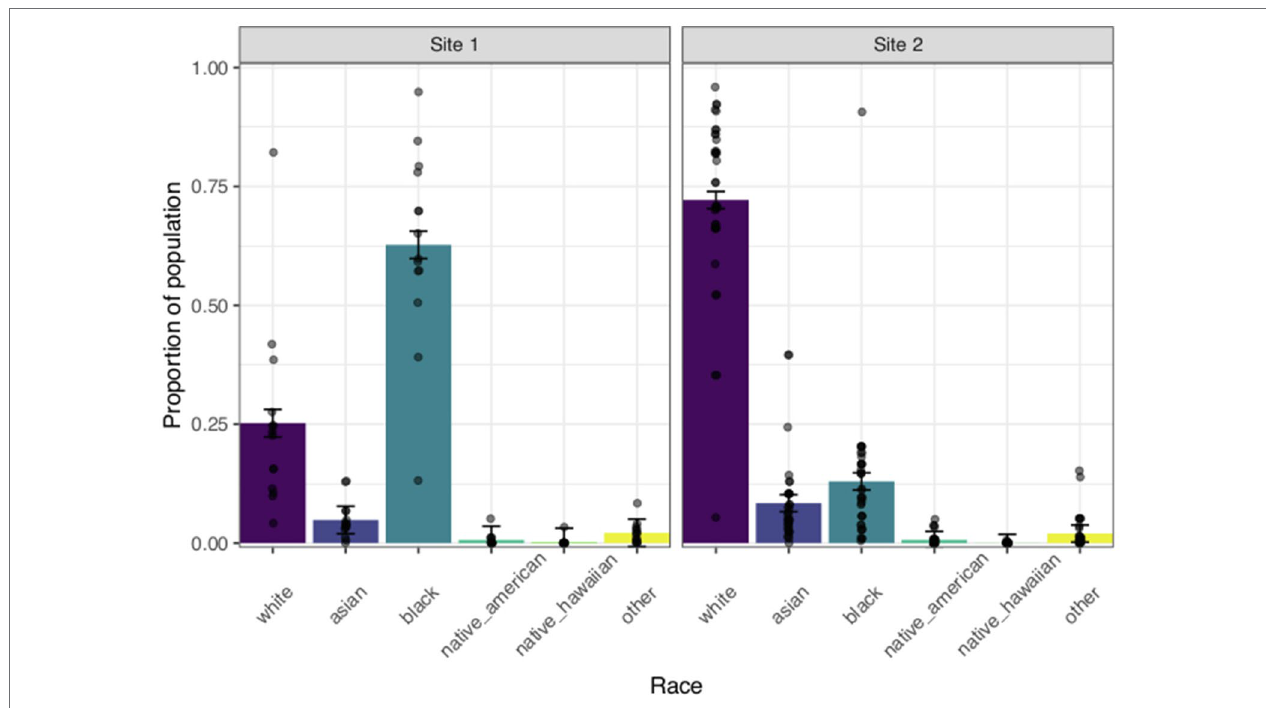
FIGURE 5 | Racial makeup by site location for respondents. Each bar represents the average proportion of each site’s population that identifies as a particular racial category. The first panel shows mean values for Site 1 and the second panel shows mean values for Site 2. Each data point represents the proportion of the population that identifies as a particular racial category for individual respondents’ census tracts. Error bars indicate